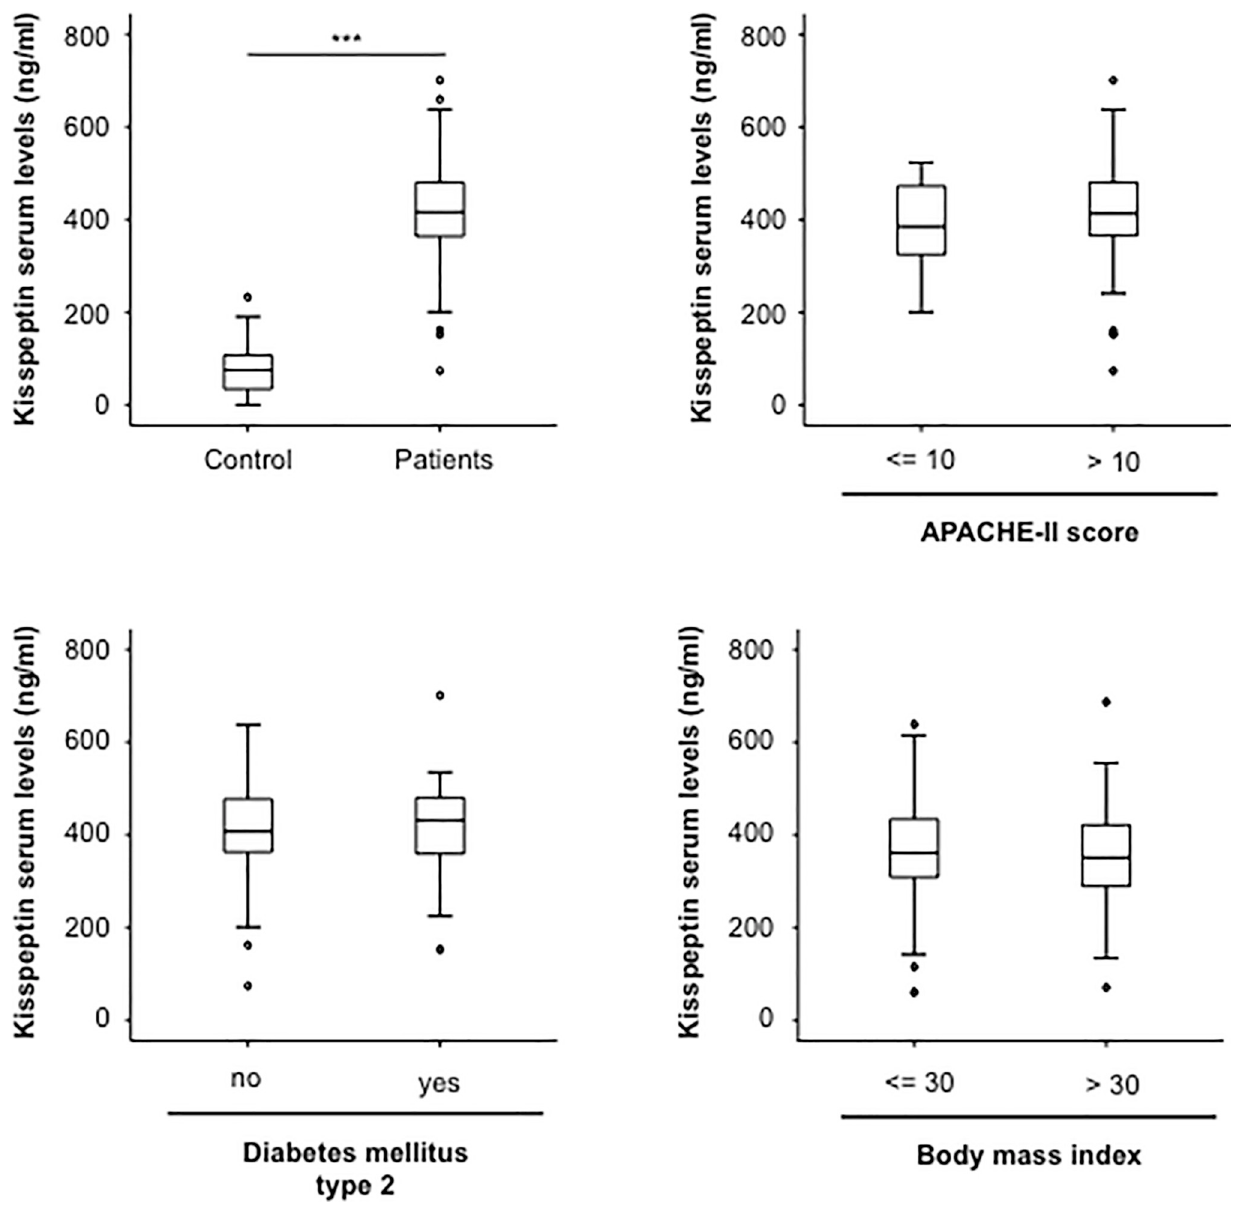
Fig 1. Kisspeptin serum concentrations in critically ill patients. (a) Serum levels of kisspeptin levels significantly elevated in critically ill patients at the time-point of admission to the ICU when compared to healthy controls. (b) Serum levels of kisspeptin were independent of the disease severity, as shown by similar kisspeptin concentrations in patients with high or low APACHE-II scores. (c) Kisspeptin levels were similar in patients with or without type 2 diabetes. (d) Kisspeptin serum levels were similar in patients with or without obesity (defined as body mass index [BMI] above 30 kg/m 2 ). ��� p < 0.001.